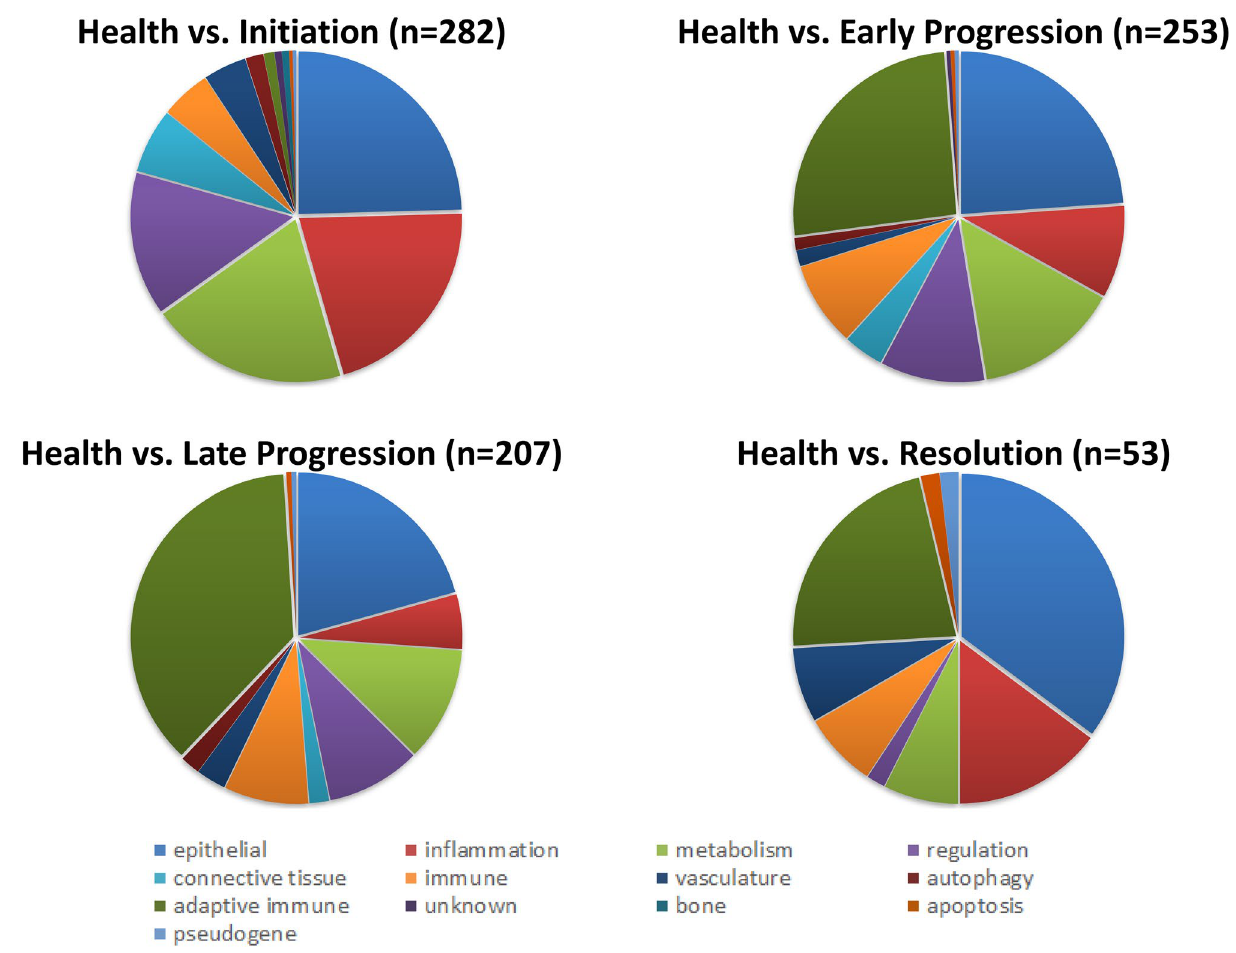
Figure 4. Depiction of the array of genes in various functional categories that differed by ≥ twofold at health versus other sampling points. Pie charts denote the proportions of each functional category of genes that comprised the overall number of genes (in parentheses) that were differentially expressed.